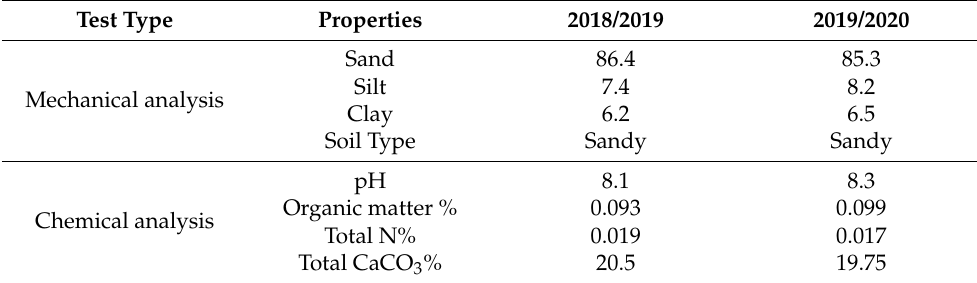
Table 1. Summary of the physical and chemical properties of the experimental site.